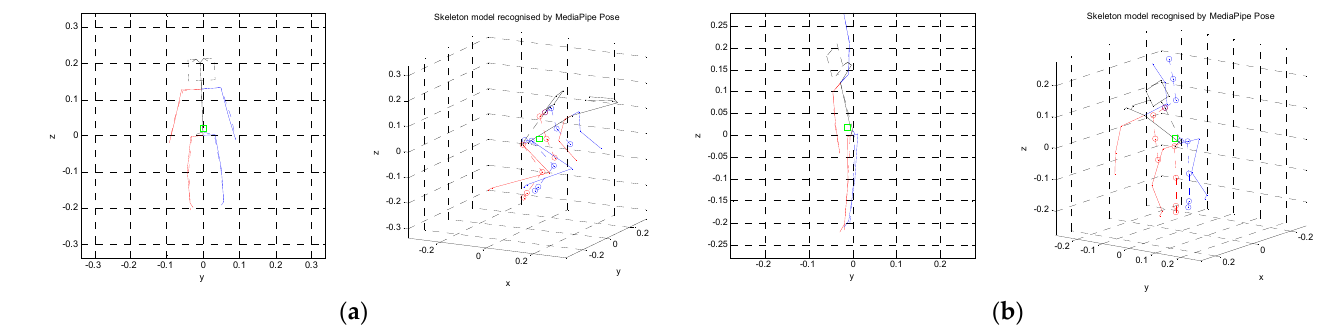
Figure 17. Comparison of 3D poses obtained from MPP (solid) and the proposed approach (dotted). ( a ) standing pose, ( b ) arm-raised pose (red line: right parts, blue line: left parts).